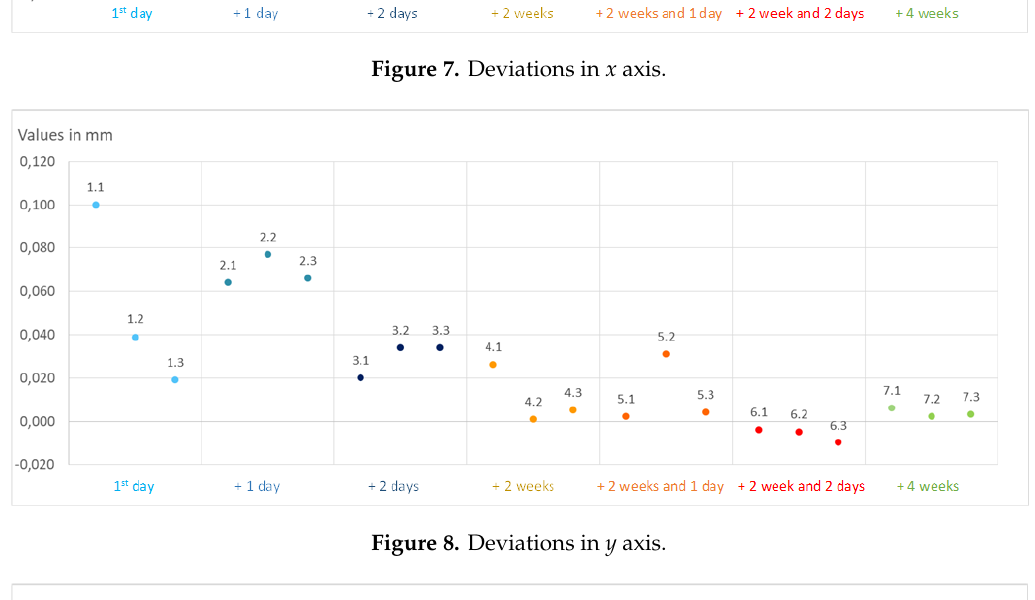
Figure 7. Deviations in x axis.